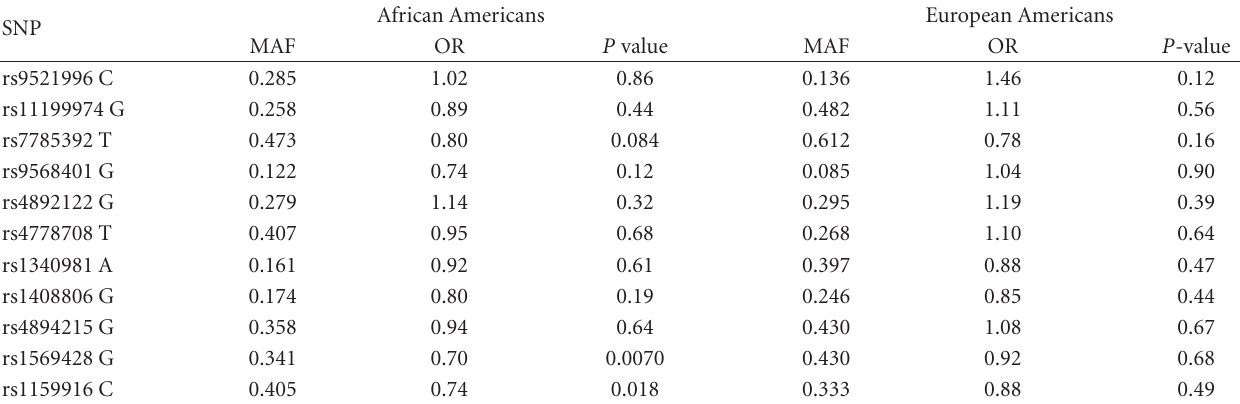
Figure 5: Diagrams depicting patterns of association observed between SNP genotype, autoantibodies, and serum IFN- α . Gene = SNP genotype at the indicated SNP, Ab = the particular autoantibody associated with that SNP, and arrows indicate the associations observed in the study. Table 3: Case control analysis of 11 SNPs tested in this study in each ancestral